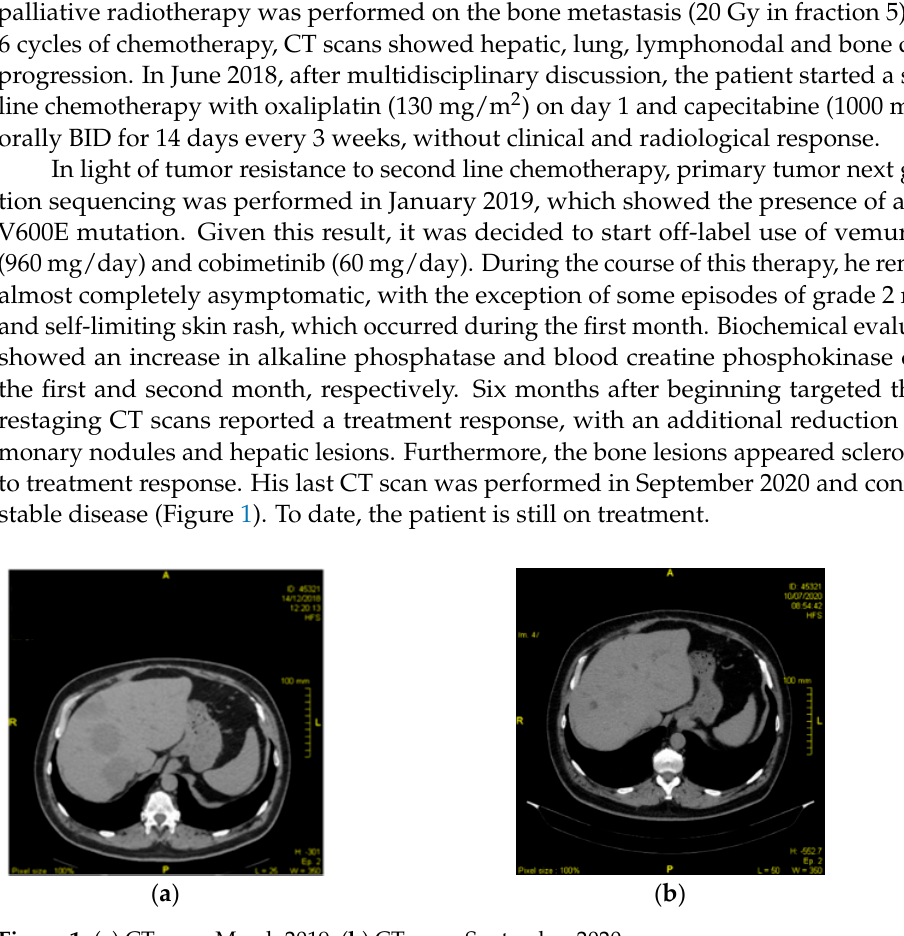
Figure 1. ( a ) CT scan, March 2019; ( b ) CT scan, September